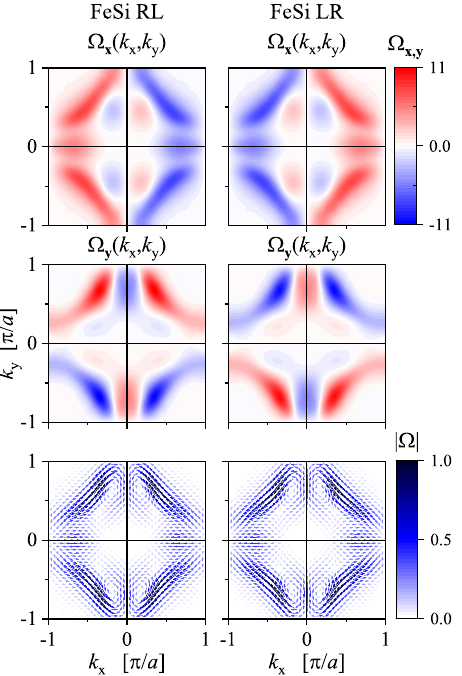
Figure 18. Berry curvature of FeSi, calculated for the two enantiomers of FeSi. The x and y components Ω x , y ( k x , k y ) in the (001) plane through the field (cid:126) Ω ( k x , k y ) are